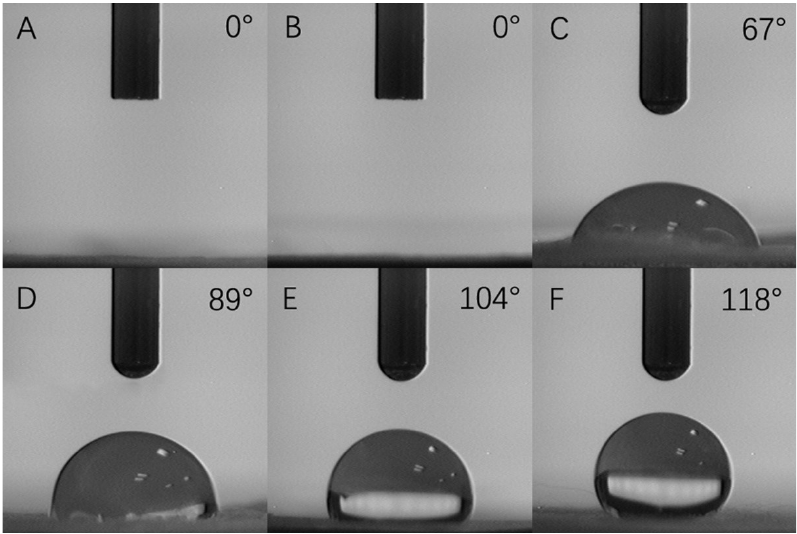
Figure 7. WCA of PDLLA/nHA membranes with different content of nHA, ( A ) 11.2%; ( B ) 10.6%; ( C ) 8.8%; ( D ) 5.5%; ( E ) 4.1% and ( F ) Control group. ( C ) 8.8%; ( D ) 5.5%; ( E ) 4.1% and ( F ) Control